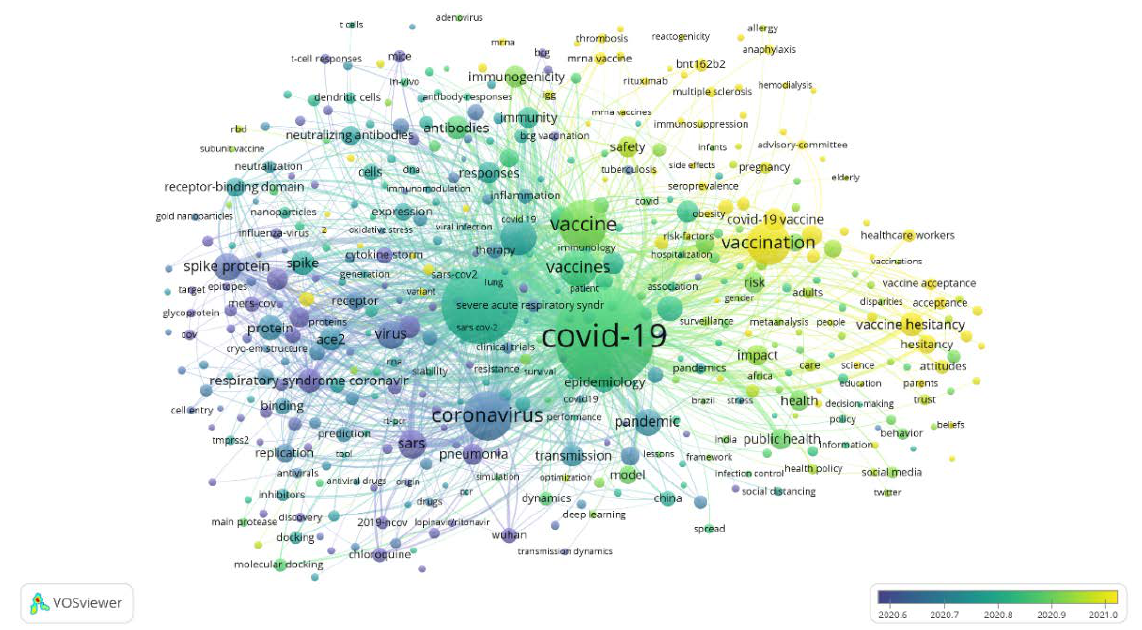
Figure 9. The major keywords of publications on the policy of COVID-19 vaccination through overlay visualization using VOSviewer.